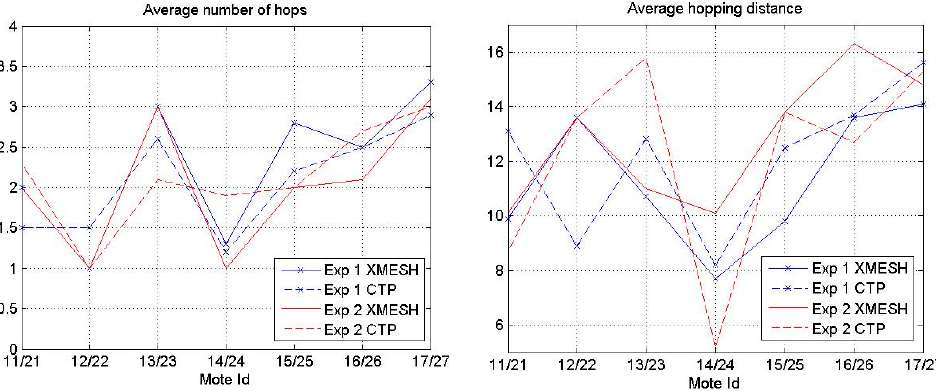
Figure 6. Average number of hops ( left ) and average hopping distance ( right ) of each mote using the XMESH and CTP protocols.